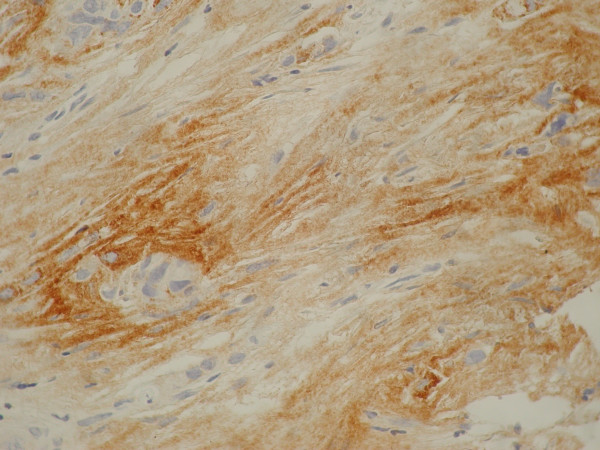
Diffuse strong immunoreactivity of extracellular matrix for TSP-1 adjacent to neoplastic cell population in a CUP case. (Original magnification ×400, counterstained with hematoxylin)